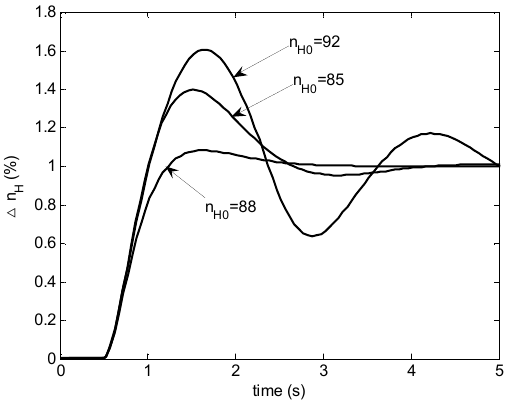
Figure 7. Step responses with a scheduled PI controller: case 2.